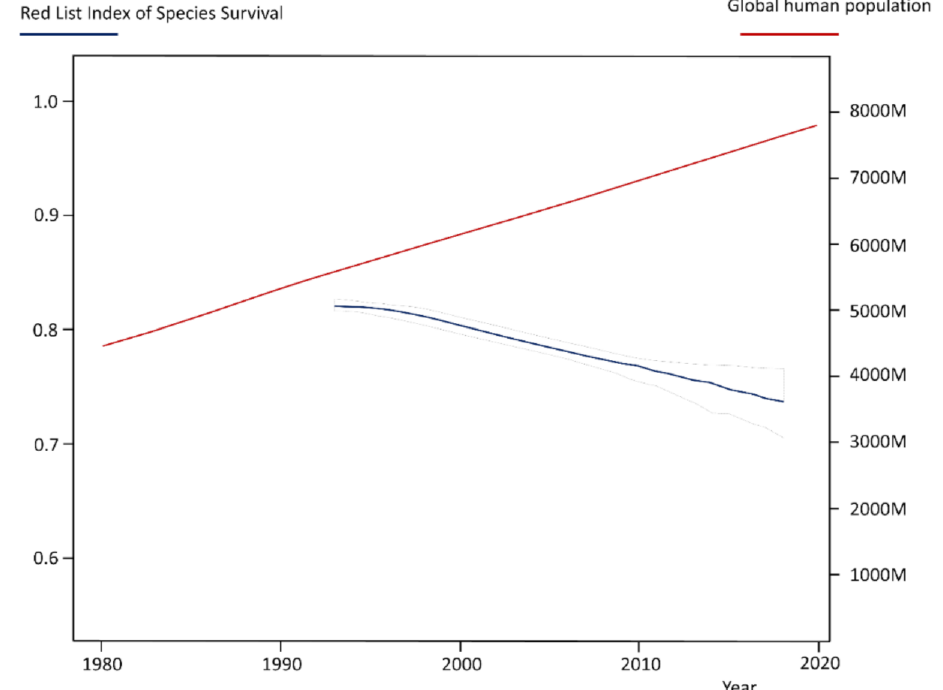
Figure 1. A constantly growing global human population (red line) goes along with a declining Red List Index (RLI) of species survival (blue line). RLI is an overall value combining the taxa: mammals, birds, amphibians, reef-forming corals and cycads. Sources: RLI: [10], human population: